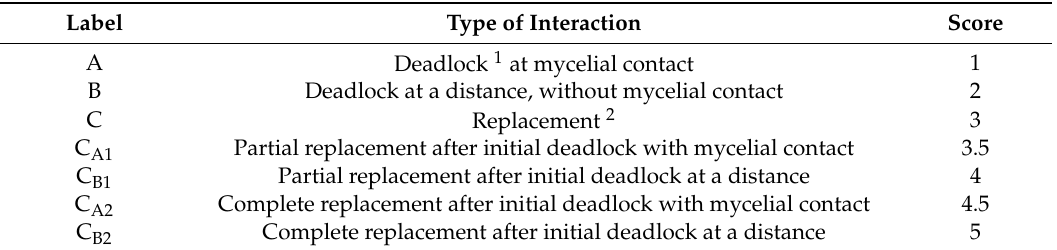
Table 2. Types and subtypes of fungal interactions with corresponding scores